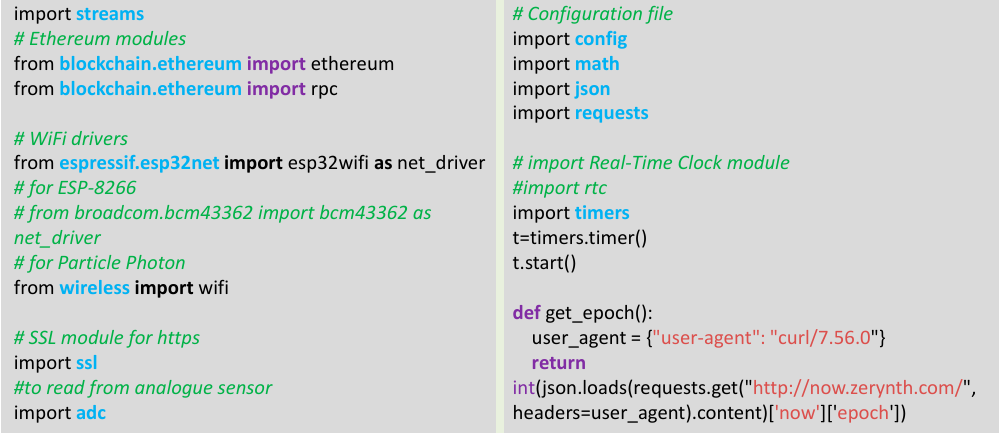
Figure 5. A Smart contract script for local Ethereum node operation .